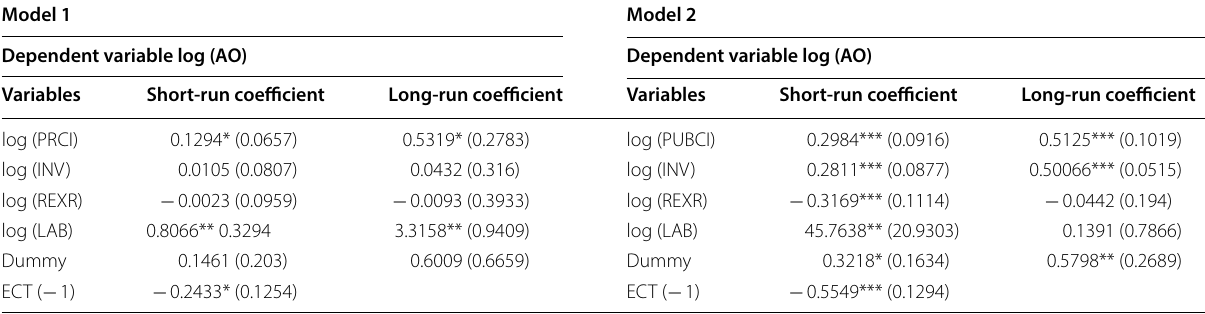
***, **, * indicates at 1%, 5% and 10% levels of significance, respectively. The figure in bracket represents standard